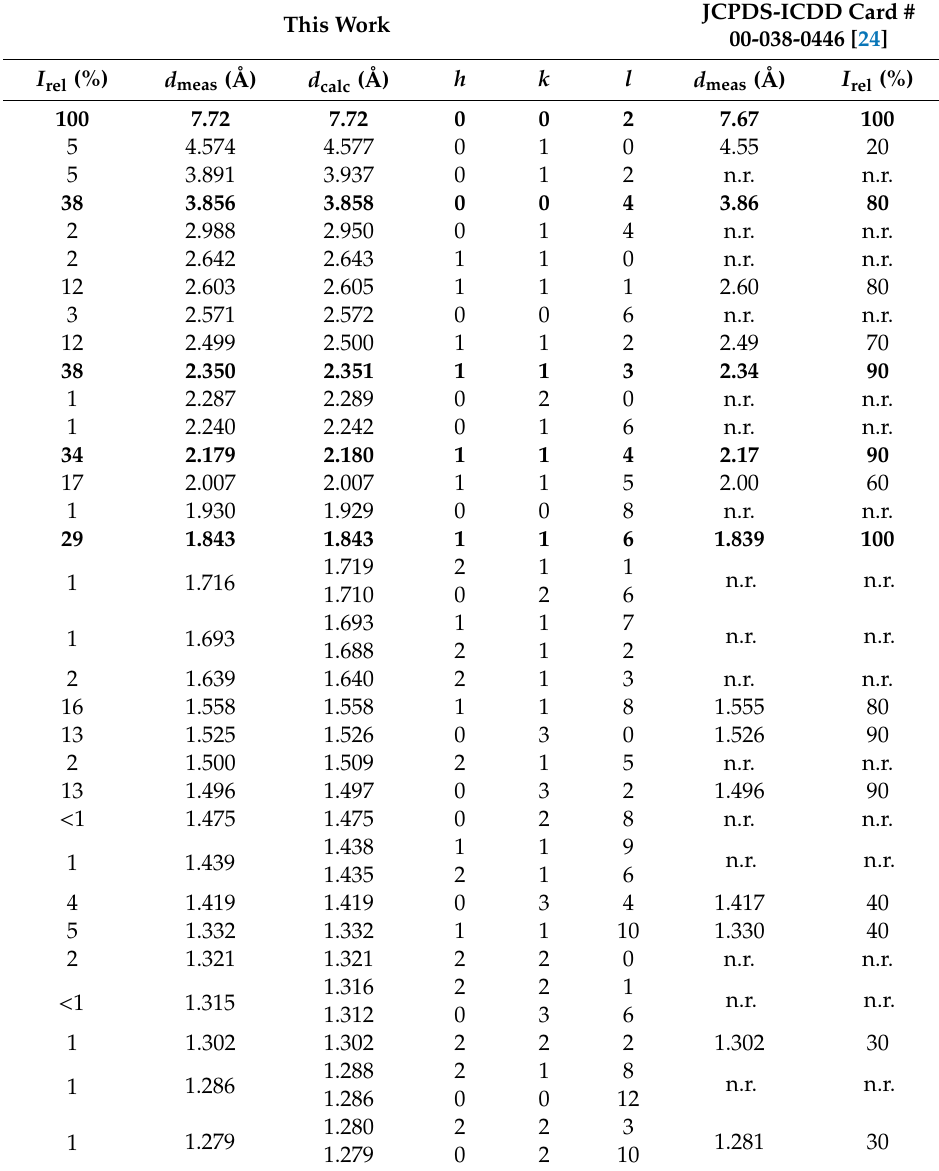
Table 7. Powder X-ray di ff raction data for